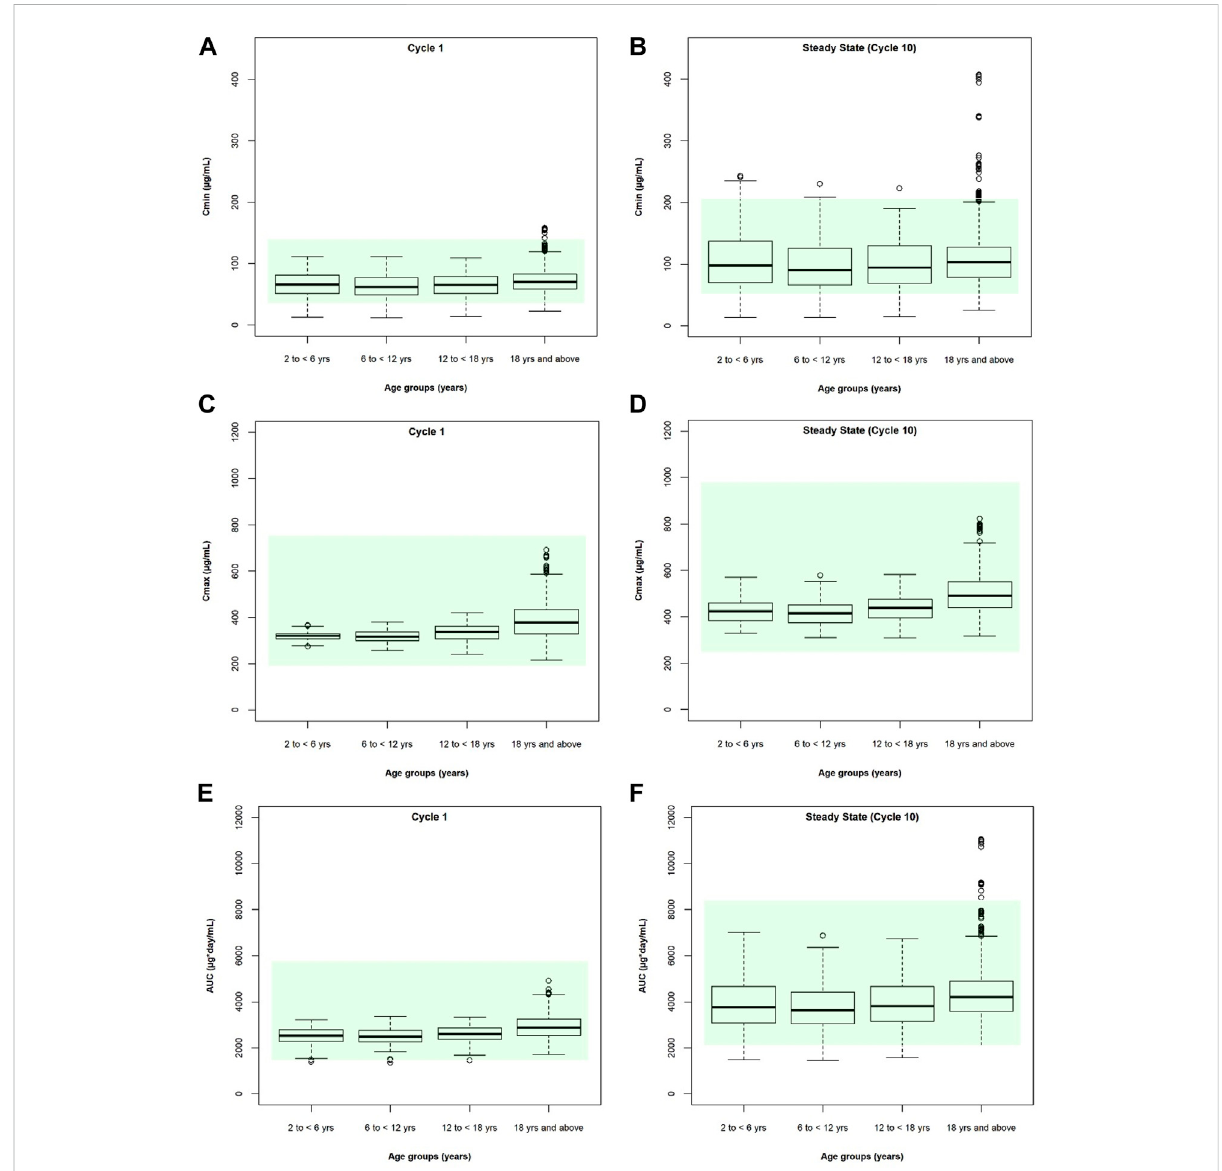
FIGURE 6 Cycle 1 and steady state (cycle 10)simulated atezolizumab (A,B) C min , (C,D) C max , and (E,F) AUC tau for pediatric(2-6 yo,6 – 12 yo, and 12 – 18 yo) andadult( ≥ 18 yo)patientsfollowingmultipleIVdosesof15 mg/kg( < 18 yo)or1,200 mg( ≥ 18 yo)atezolizumabQ3W.Theboxrepresentsthemedian value and interquartile range; error bars represent the 5th and 95th percentiles. Circles represent individual subjects outside of the 5th to 95th percentiles. Shaded area represents the simulated adult acceptable criteria (50% – 200% of the adult median